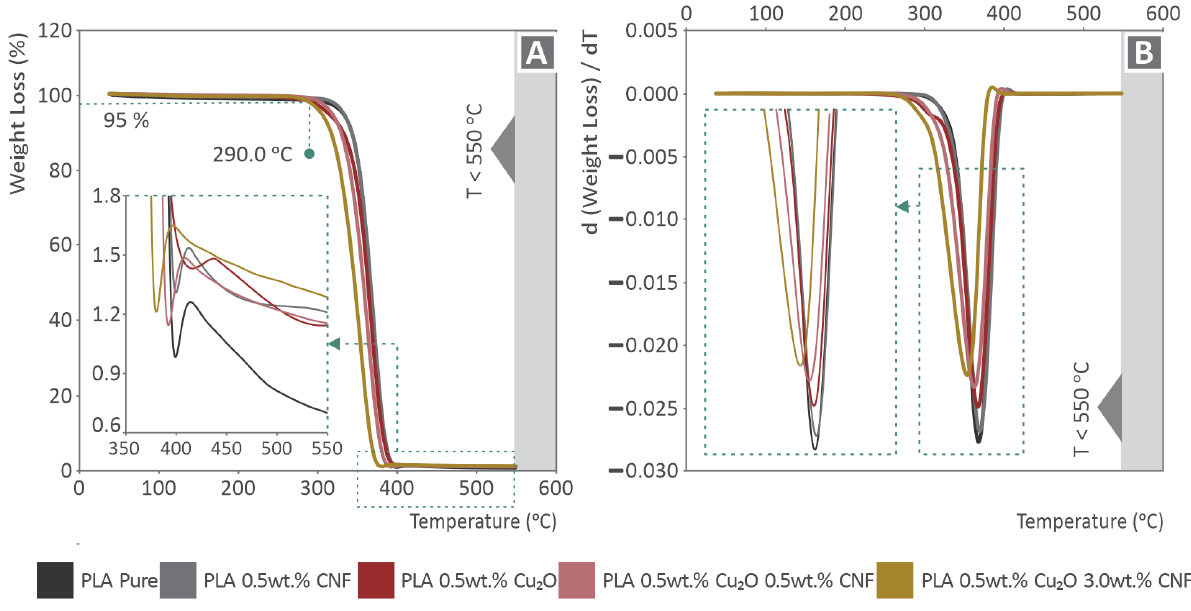
Figure 4. TGA results for all materials tested: ( A ) weight loss (%) vs. temperature; ( B ) DTGA graph depicting the weight loss ratio vs.